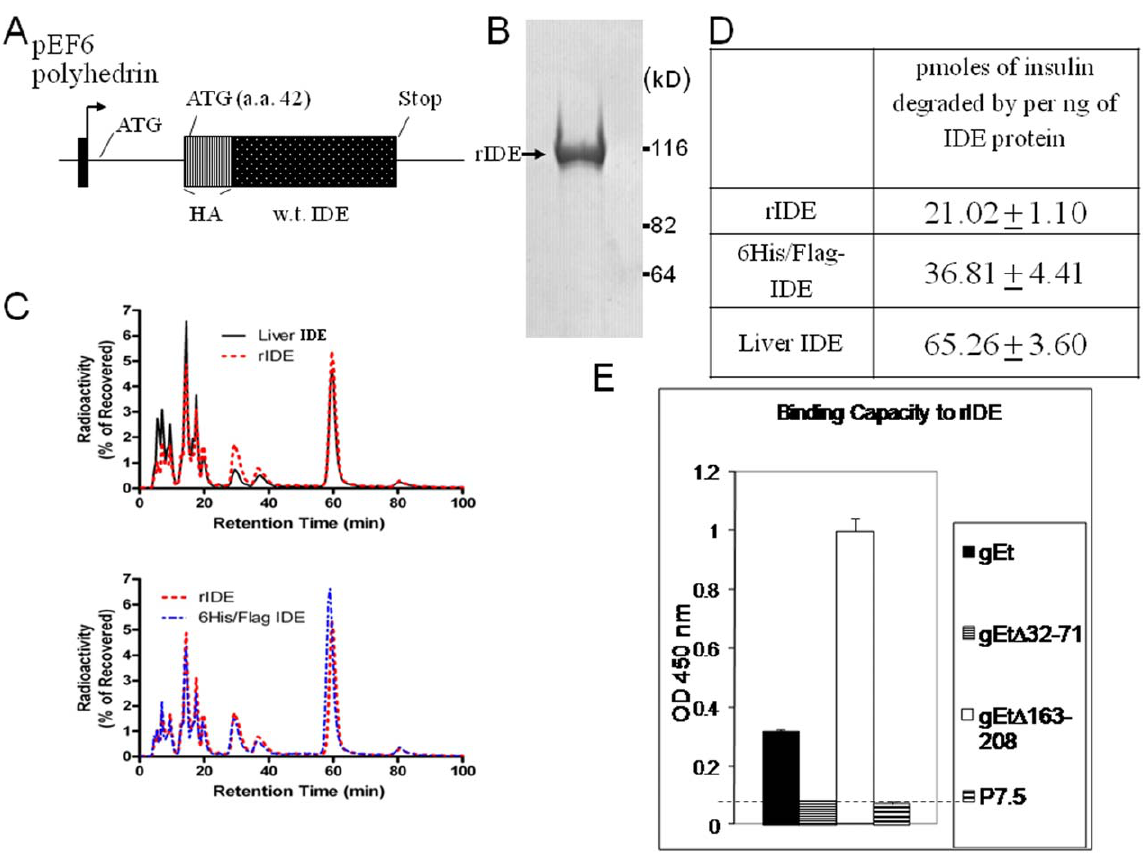
Figure 1. rIDE is expressed in insect cells, degrades insulin, and binds to VZV gE. (A) Structure of HA-tagged rIDE and its promoter in recombinant baculovirus. (B) rIDE was purified, eluted under native conditions, and stained with Coomassie Blue. Soluble rIDE is expressed as a 110 kDa protein in insect cells. (C) HPLC profiles of insulin degradation fragments observed after co-incubation of radiolabeled insulin with rIDE expressed in insect cells, endogenous IDE extracted from rat liver (top panel), or recombinant IDE (6His/Flag-IDE) expressed in eukaryotic cells (bottom panel). (D) Insulin-degrading enzymatic activities of IDE proteins. (E) ELISA assay for binding of rIDE to gEt, gEt lacking the IDE binding domain (gEt D 32-71), gEt defective in binding to VZV gI (gEt D 163-208), and a negative control protein (P7.5, vaccinia 7.5 protein). The horizontal dotted line indicates the level of nonspecific binding based on the control protein.